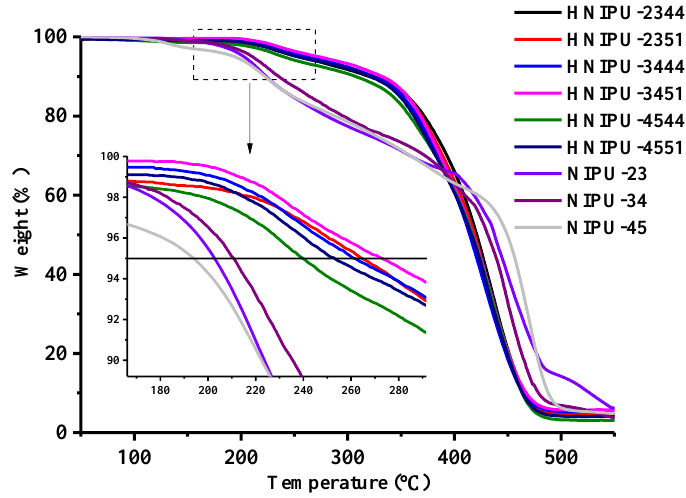
Figure 3. Dynamic mechanical analysis (TGA) cures of the different HIPUs and HNIPUs.